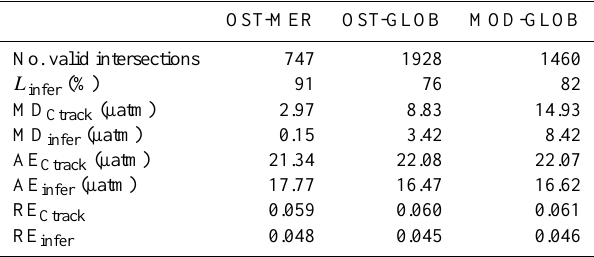
Table 4. Mean difference, absolute error and relative error of p CO 2 values obtained from CarbonTracker and p CO 2 values inferred at super resolution with respect to values of p CO 2 measurements during the QUIMA2005/QUIMA2006/QUIMA2008 cruises in the Benguela